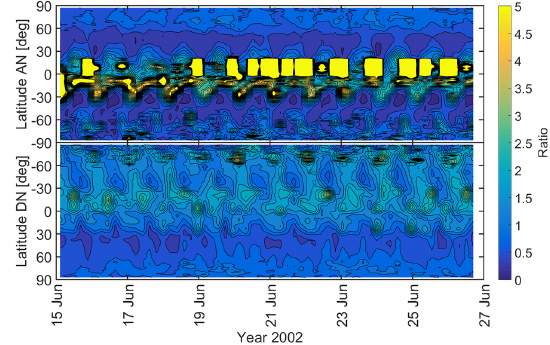
Figure 14. Density ratio (GITM / CHAMP) as a function of time and latitude for “case e” (LTAN = 07:38; LTDN = 19:38; h apogee = 379km; h perigee = 350km).